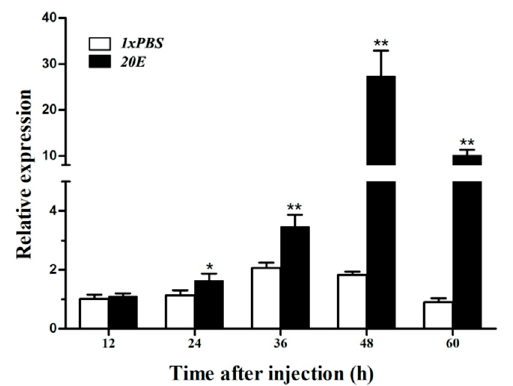
Figure 7. Expression patterns of HvATG8 after 20E treatment (n = 30 larvae in each biological replicate). The 20E treatment results were compared relative to those after injection with 1 × PBS (control). Error bars mean ± standard error of three biological replicates. Two-way analysis of variance followed by Students’ t-test was used. * p < 0.05, ** p < 0.01.